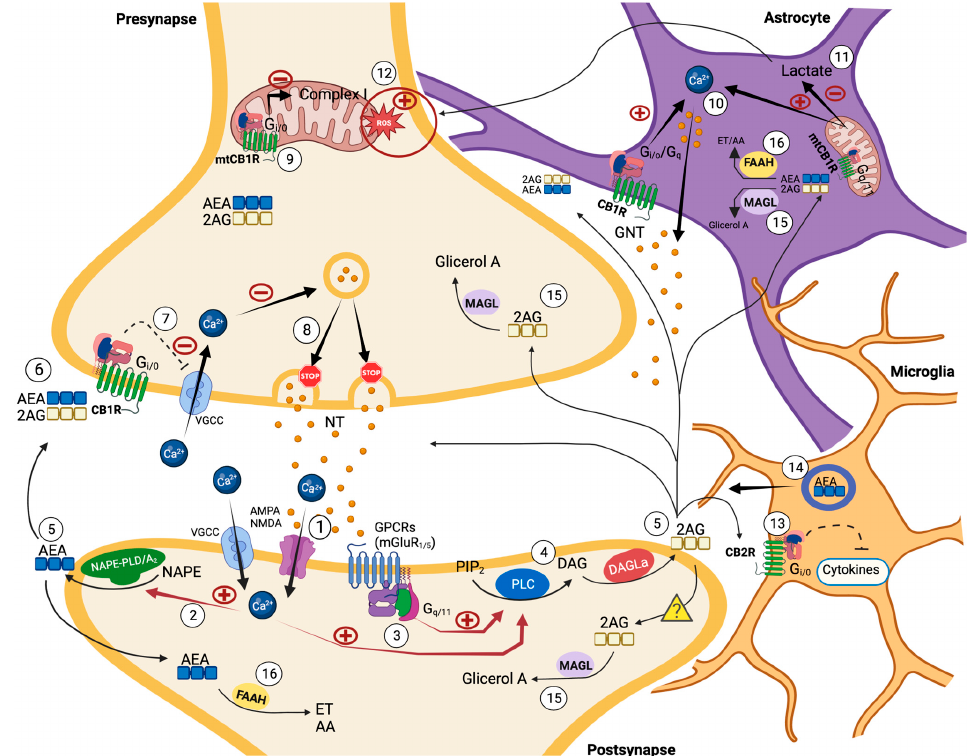
Figure 3. Model of endocannabinoid (eCBs) signaling at central synapses. In neurons: (1) The activa- tion of ionotropic receptors (e.g., α -amino-3-hydroxy-5-methyl-4-isoxazolepropionic acid receptor (AMPA) and N-methyl-D-aspartate receptor (NMDA)) on postsynaptic neurons by neurotransmitters (NTs) and/or the depolarization of the neuronal membrane triggers the entry of Ca 2+ through the voltage-gated Ca 2+ channels (VGCCs). (2) The increase in intracellular Ca 2+ activates the enzymes involved in the synthesis of arachidonoyl ethanolamide (AEA), including NAPE-phospholipase D (NAPE-PLD) and/or phospholipase A2. (3) The entry of Ca 2+ through the aforementioned mecha- nisms and/or the activation of G protein-coupled receptors (GPCRs) coupled to Gq protein alpha subunits (G α q/11s) (e.g., group I metabotropic glutamate receptors (mGluRs) and muscarinic acetyl- choline receptor (mAChR) subtypes M1/3) by neurotransmitters (NTs) activates phospholipase C (PLC), (4) which hydrolyzes phosphatidylinositol 4,5-bisphosphate (PIP2) into diacylglycerol, which is converted into 2-Arachidonoylglycerol (2-AG) by diacylglycerol lipase α (DAGL α ). (5) Following their de novo synthesis, AEA and 2-AG are released into the synaptic space. (6) Once released, they travel “backwards” and activate the cannabinoid receptor 1 (CB1R) G α i/o -GPCRs located on presynaptic neurons, (7) which through G i/0 proteins block the VGCCs, resulting in (8) inhibition of the release of NTs by the presynaptic neuron. (9) In the presynaptic neuron, AEA and 2-AG also activate mitochondrial CB1Rs (mtCB1Rs) with probable consequent inhibition of complex I activity [58], which modulates the organelle’s respiration and energy production. In glial cells, on astrocytes the presence of CB1R has been reported on both the cell membrane (Ref. 41F) and the mitochondrial membrane [59]. (10) The activation of CB1R and mtCB1R leads to an increase in Ca 2+ , which promotes the release of gliotransmitters (GNTs) into the synapse. Furthermore, (11) the activation of mtCB1R leads to a reduction in the glycolytic production of lactate in astrocytes, which results in (12) redox stress in the presynaptic neuron [60]. (13) On microglia, eCBs activate cannabinoid receptors 2 (CB2Rs) by blocking the production of cytokines [61]. (14) Moreover, AEA released from microglia via macrovesicles may contribute to endocannabinoid signaling at the central synapse [62]. eCB catabolism: (15) 2-AG and (16) AEA are inactivated by monoacylglycerol lipase (MAGL) and fatty acid amide hydrolase (FAAH), respectively, in glycerol A and ethanolamine + AA in both astrocytes and neurons